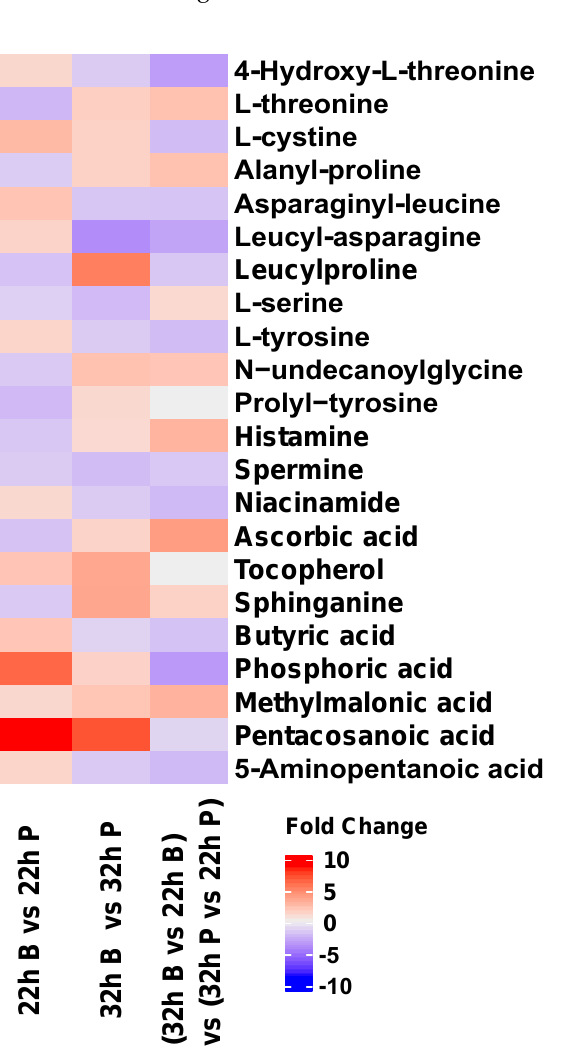
Figure 7. Heatmap of key metabolites during biofilm formation. Red represents upregulated and blue represents